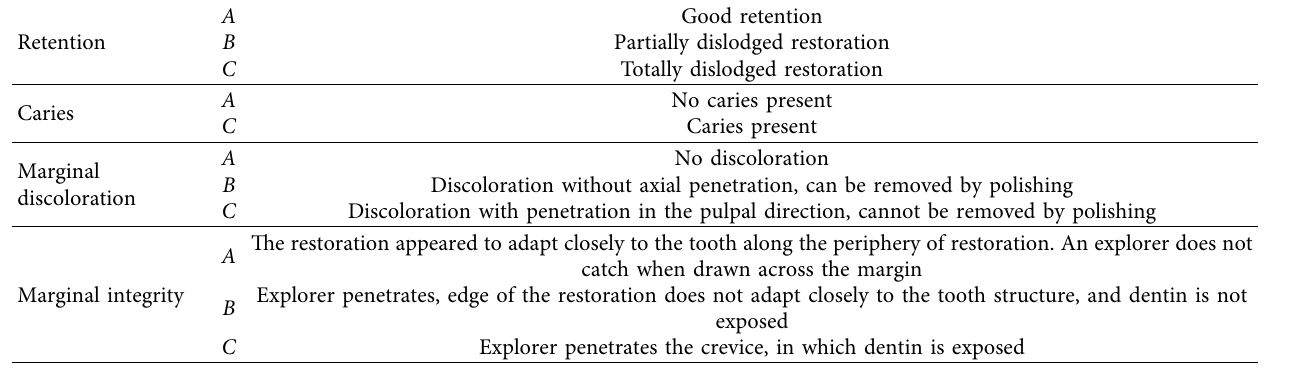
Table 1: Key parameters determining the overall clinical success rate using modified USPHS